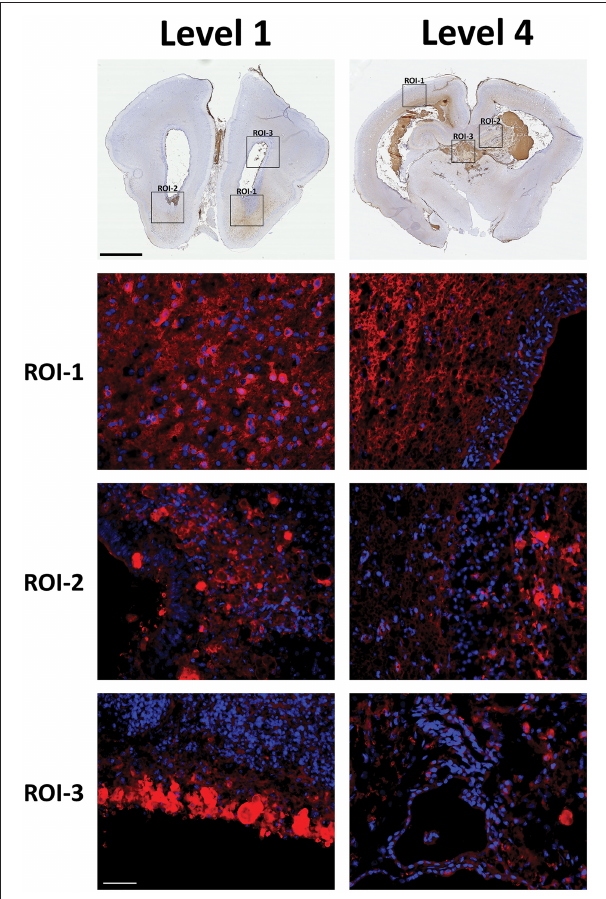
FIGURE 4 | Hb immunolabeling within the brain following preterm rabbit pup IVH. The presence of Hb following IVH was characterized by Hb (displayed as red) immunolabeling of selected regions of interests (ROI) of peroxidase activity corresponding areas, recorded in parallel sections. Rabbit pups with IVH or sham controls were euthanized at 72h of age followed by saline and freshly prepared 4% PFA perfusion. Afterwards the brains were dissected out from the skulls and immersed in 4% PFA. Brains were prepared and sections at the levels of rostral forebrain (Level 1) and caudal midbrain (Level 4), were immunolabeled for Hb as described in the Materials and Methods Section. Fluorescence microscope analyses were performed on a wide-field Olympus microscope (IX73) and slide scanning were performed on a Hamamatsu NanoZoomer 2.0-HT Digital slide scanner: C10730. Scanning was performed with a 40 × magnification lens. Images used for illustrations, from ROI’s, were grabbed with the viewer software NDP.view2 Viewing software. DAPI labeled cell nuclei are blue. Scale bar of slide scan images indicate 2.5mm and of ROI images indicate 25 µ